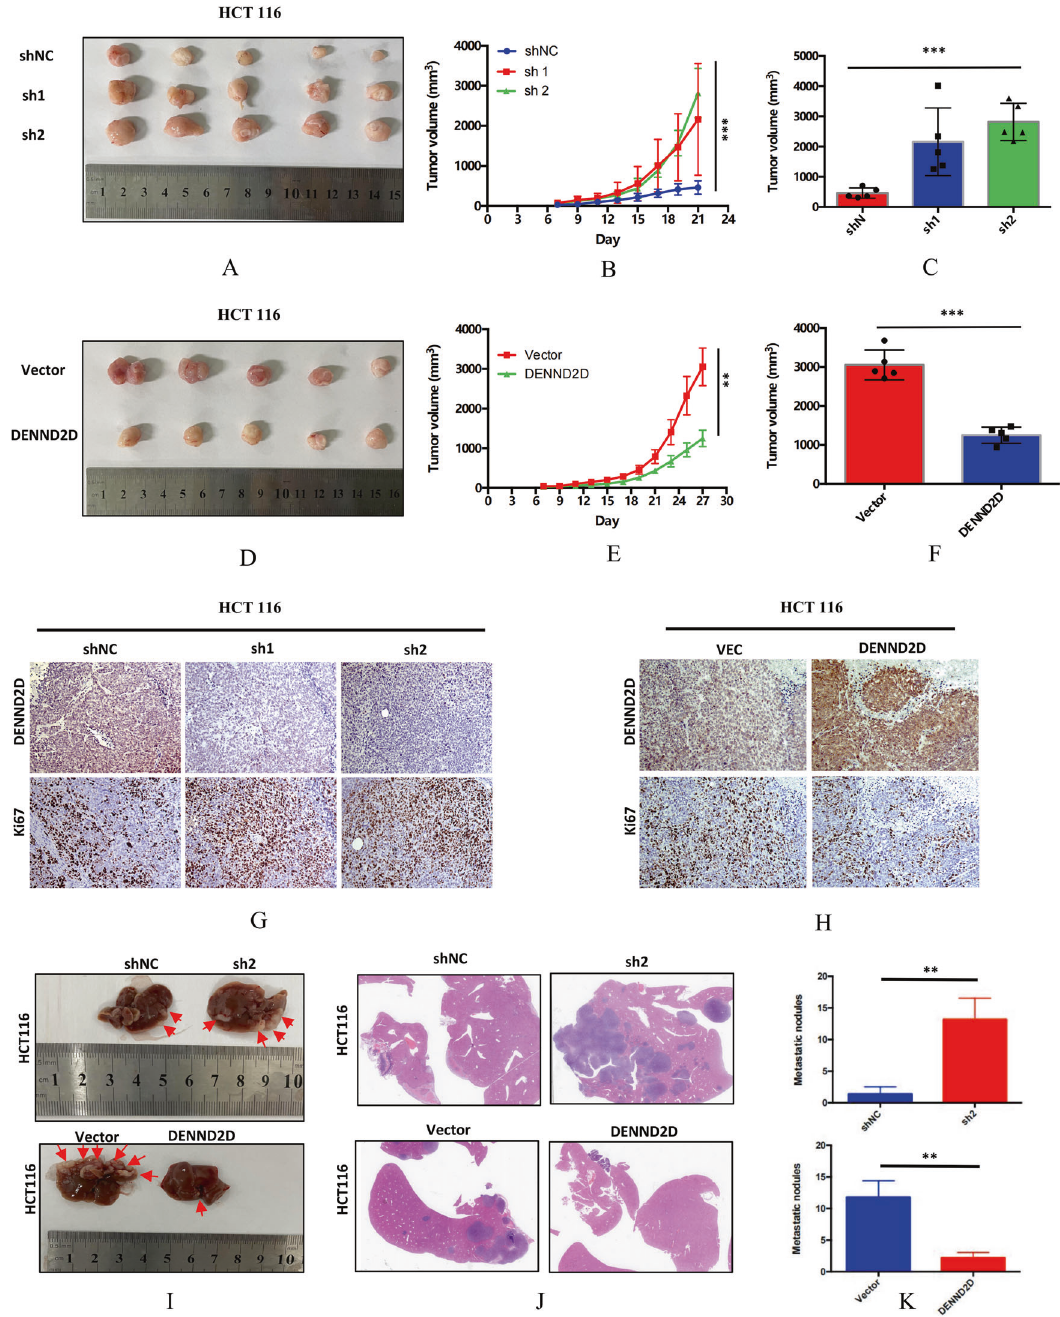
Fig. 4 DENND2D suppressed CRC cell proliferation and metastasis in vivo. A – C Volumes of xenografts generated from HCT116-sh1/sh2 and HCT-shNC cells. D – F The volumes of xenografts generated from HCT116 and HCT overexpressing cells. G , H DENND2D and Ki67 expression in xenografts generated from HCT116-sh1/sh2, HCT-shNC, HCT116, and DENND2D-overexpressing cells. I – K Liver metastasis model generated by spleen injection of HCT116-sh2, HCT-shNC, HCT116, and DENND2D-overexpressing